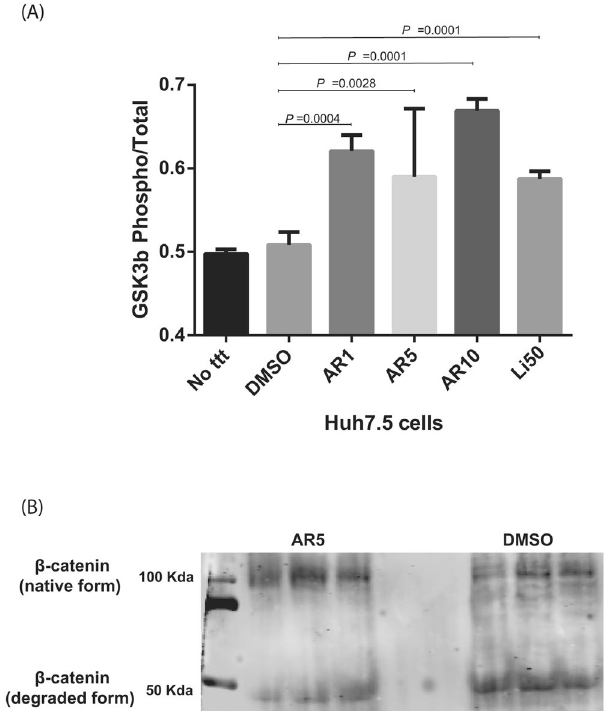
Figure 1. Increase in phosphorylated GSK3 β and decrease in β -catenin degradation after treatment with GSK3 inhibitors. ( A ) Huh7.5 cells treated with AR1, AR5, AR10 and Li50 GSK3 inhibitors were harvested for protein. 25 µ g protein was used to identify total and phosphorylated protein levels using ELISA. Values are expressed as the ratio of the phosphorylated to total GSK3 β . Values = mean ± SD of three measurements in the same experiment. ( B ) Western blot analysis of Huh7.5 cell lysates for both the native and degraded form of β -catenin using specific mAb, shows that inhibition of GSK3 β inhibits the degradation of β -catenin (n = 3 independent experiments). mAb, monoclonal